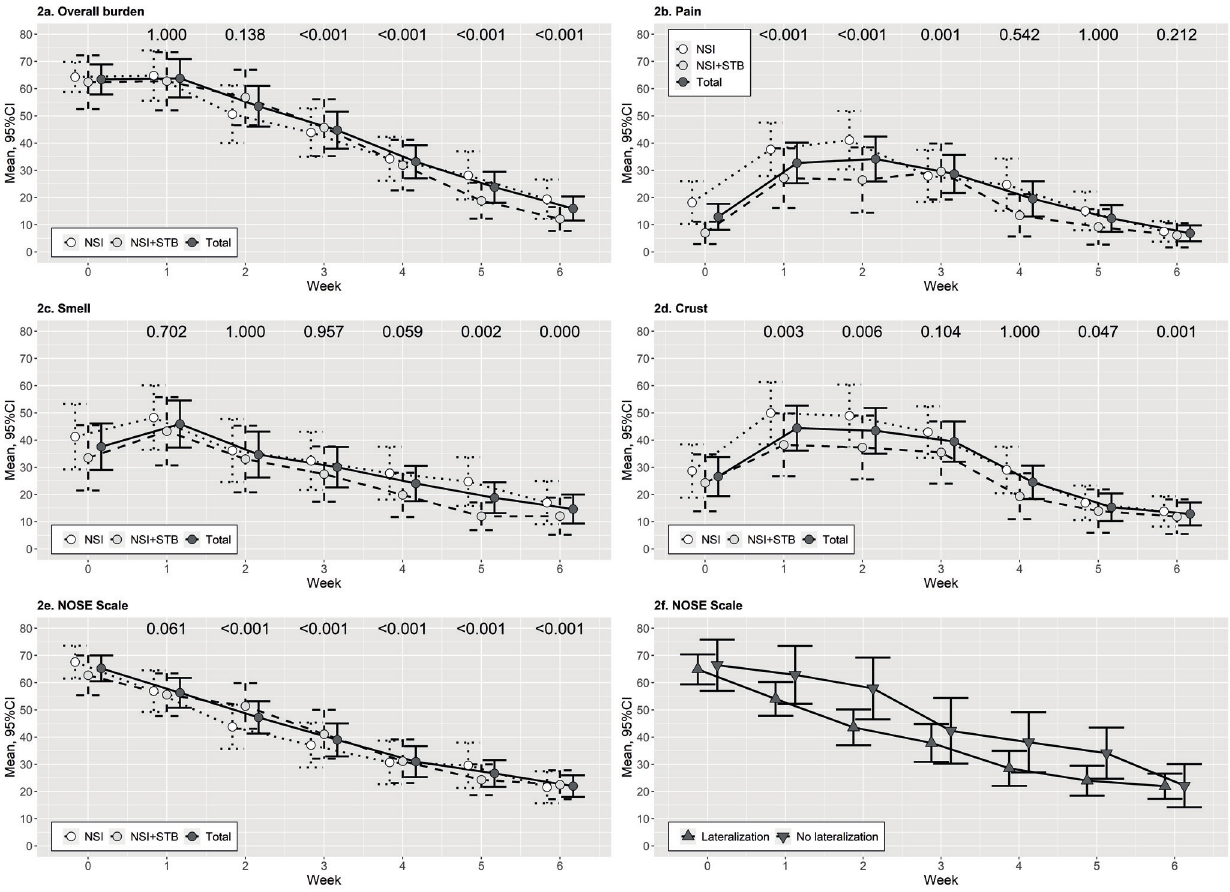
Figure 3. Correlation of preoperative mouth breathing in % and postop- erative NOSE score in the patient